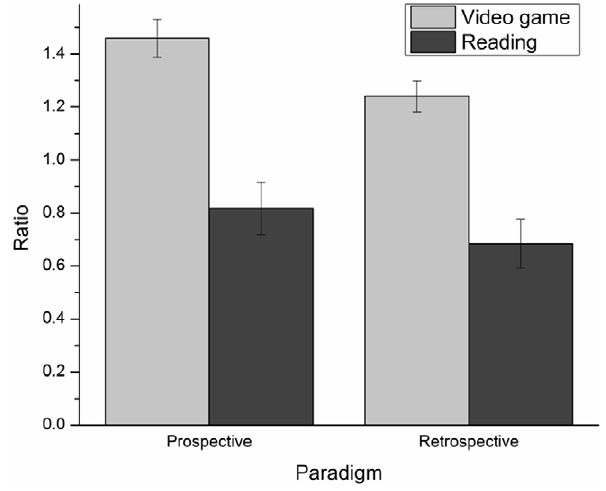
Figure 1. Ratio’s mean and standard error for each task and for each paradigm.